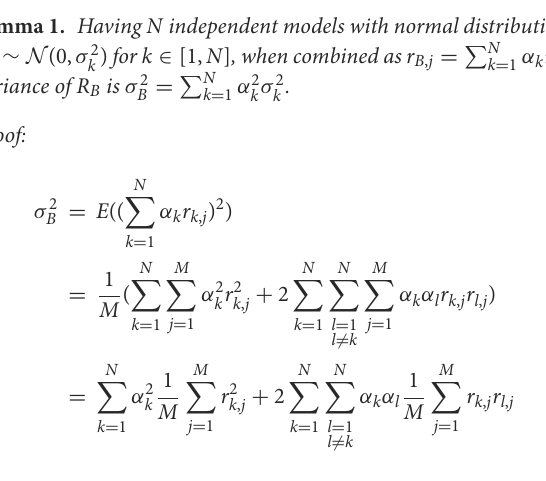
N α k ˆ y k , j X k = 1